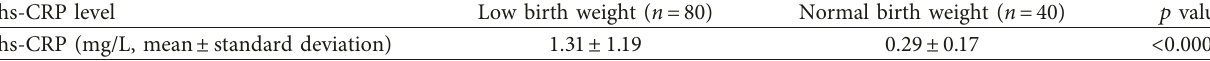
Table 5: The difference in serum hs-CRP level between the low birth weight and normal birth weight group.